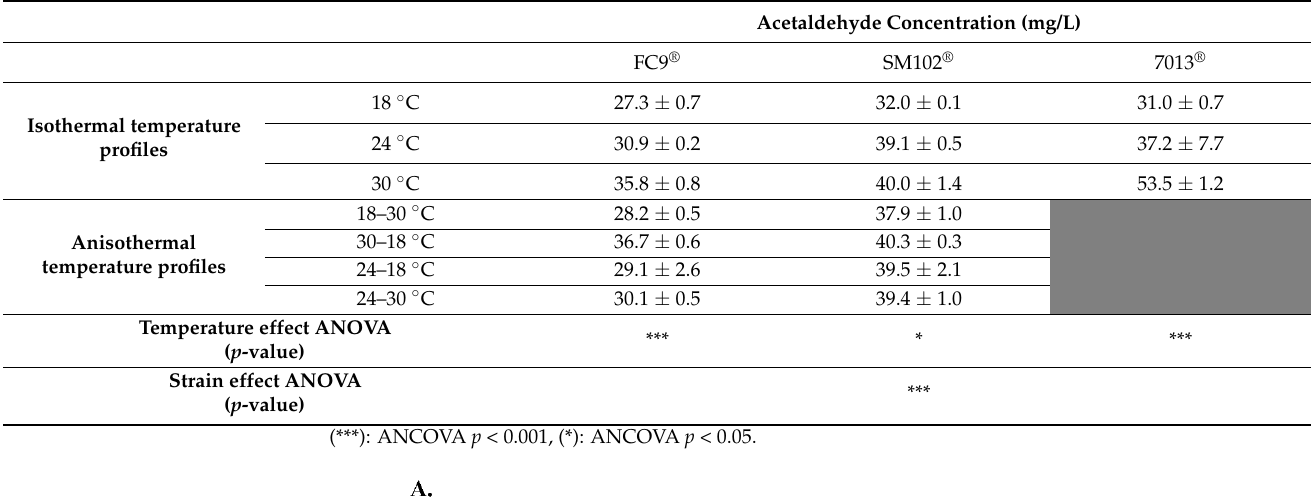
Table 1. Concentration of acetaldehyde accumulated in the extracellular medium at the end of the growth phase. ANOVA statistical analysis: effect of temperature and strain.